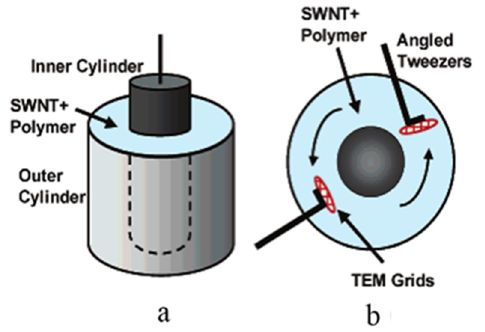
Figure 8. Schematic representation of the experimental setup: ( a ) Concentric cylinder arrangement in the Brookfield viscometer; ( b ) TEM sample retrieval and preparation. Reproduced with permission [70]. Copyright 2006, American Chemical Society.